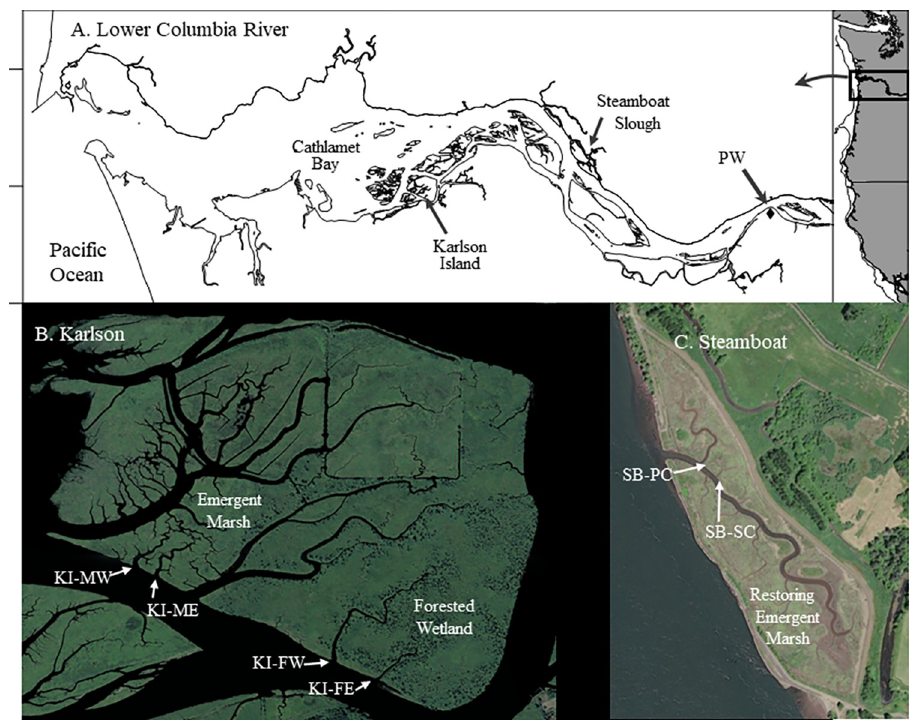
Fig 1. A. Location of study areas and sampling sites in the LCRE. B. Karlson Island. C. Steamboat Slough. https://doi.org/10.1371/journal.pone.0282655.g001 averaged, and recorded every 5 or 10 min (depending on sampling date). For convention, we assigned a positive value to ebb velocity and discharge. (Note this convention differs among studies in the literature.)